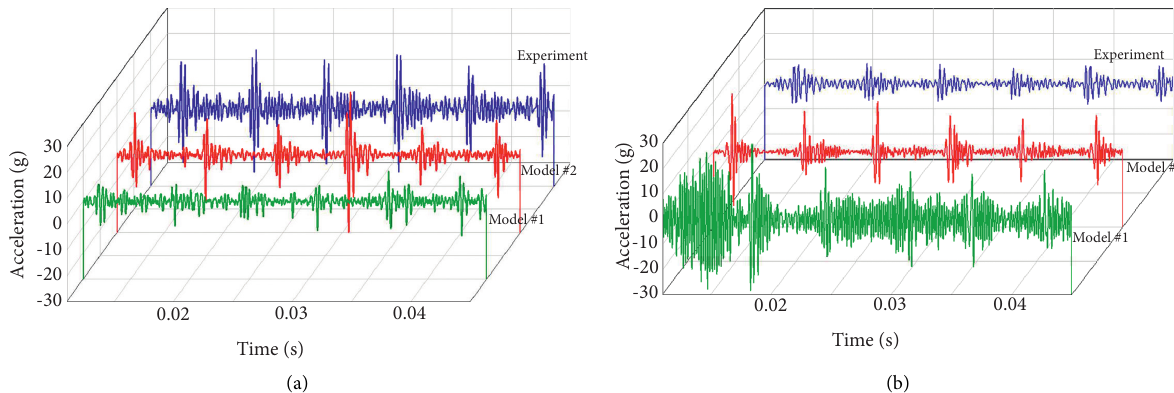
Figure 5: Time-domain acceleration signals from (a) the top surface of the bearing housing and (b) the side surface of the bearing housing.